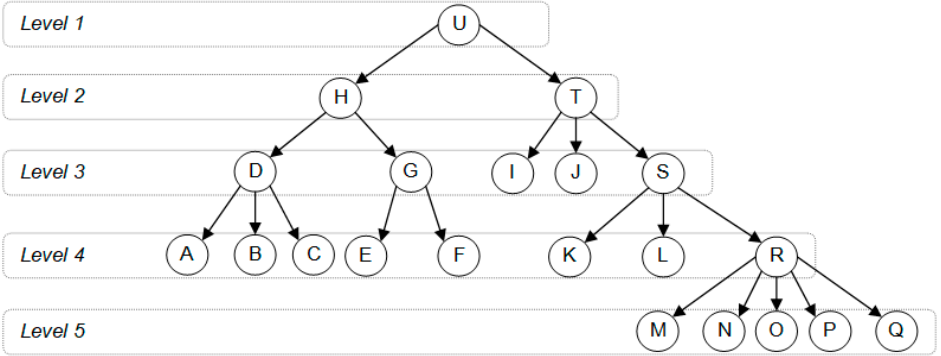
Figure 4. Example structure of course/task competency tree.